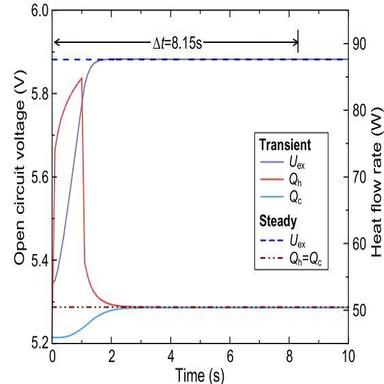
Determination of the unified time duration Δt for each stepped temperature rise.